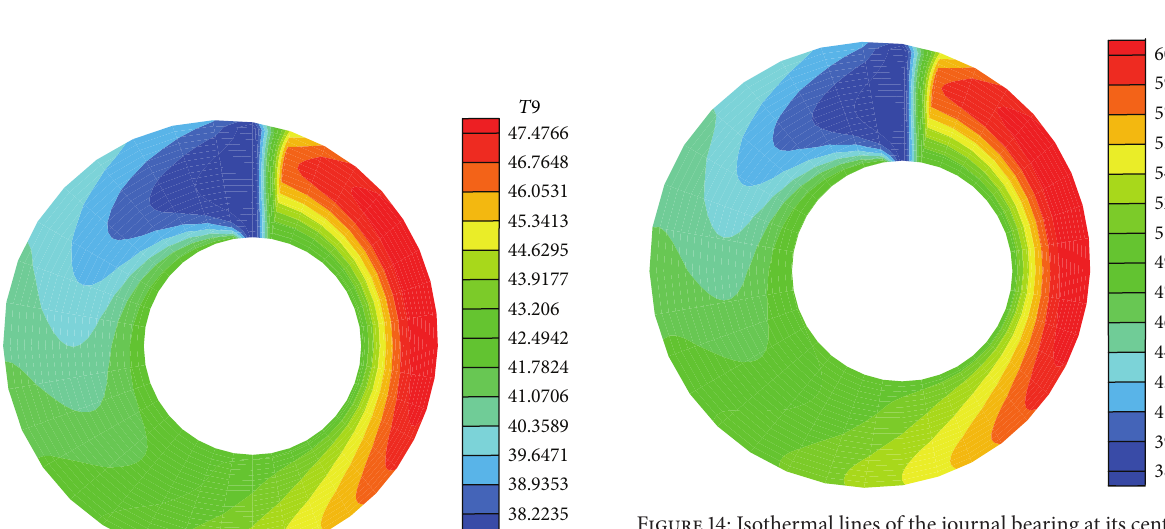
Figure 13: Isothermal lines of the journal bearing at its central plan for 𝜀 = 0.8 and 𝑛 = 1 .